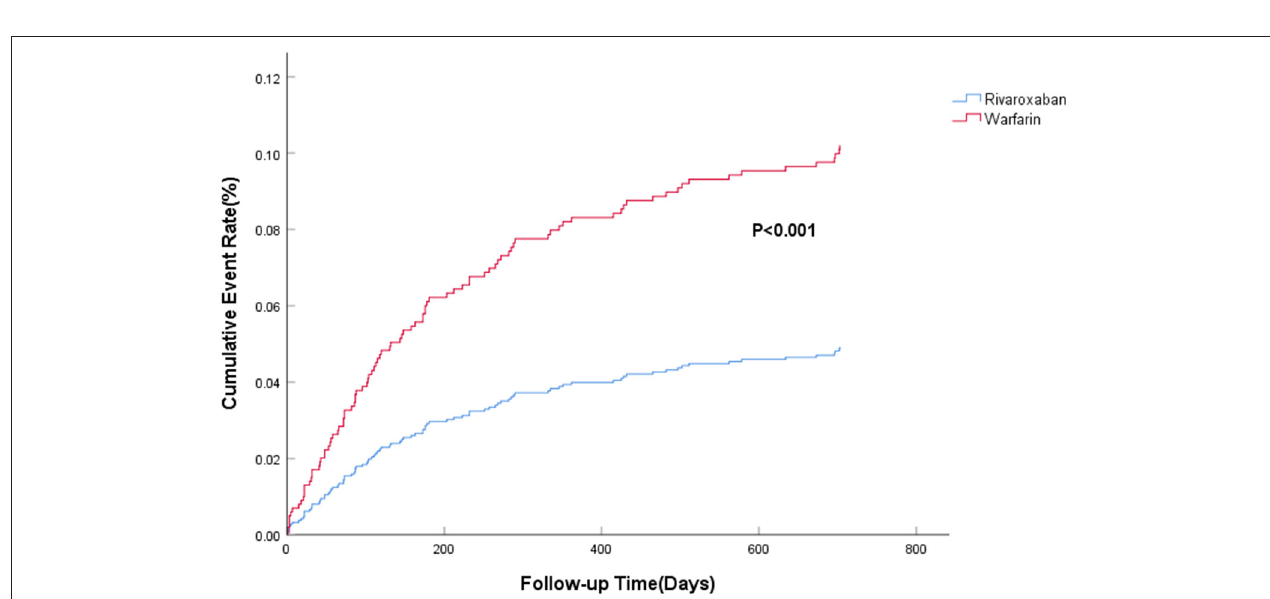
FIGURE 2 | The primary safety risk end